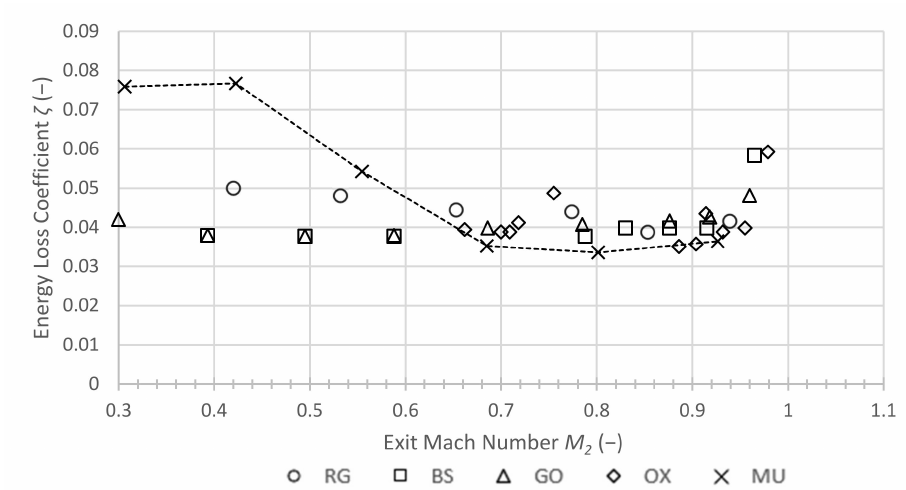
Figure 7. Loss coefficient ζ against exit Mach number M 2 for NOVEC 649 and literature data obtained for air and smooth blades (adapted from Kiock et al. [9]; RG = von Karman Institute for Fluid Dynamics, GO = German Aerospace Centre (DLR) Göttingen, BS = TU Braunschweig, OX = Oxford University).